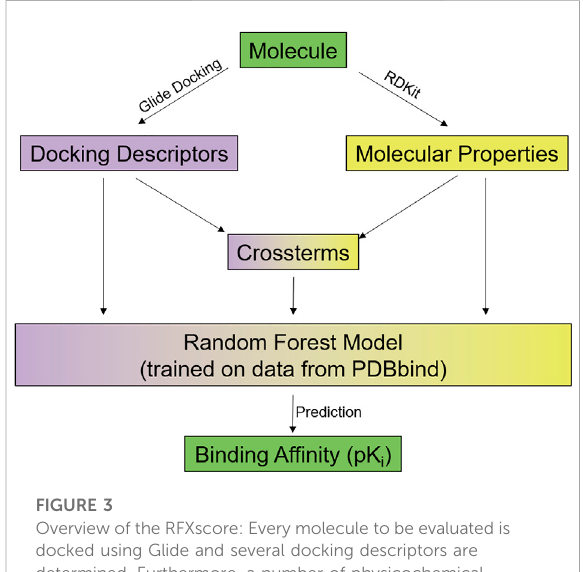
FIGURE 3 Overview of the RFXscore: Every molecule to be evaluated is docked using Glide and several docking descriptors are determined. Furthermore, a number of physicochemical properties is computed by RDKit. The docking descriptors, the RDKit properties, and some crossterms of both are put into a random forest model that predicts the binding af fi nity for the compound. Further details see text and Supporting